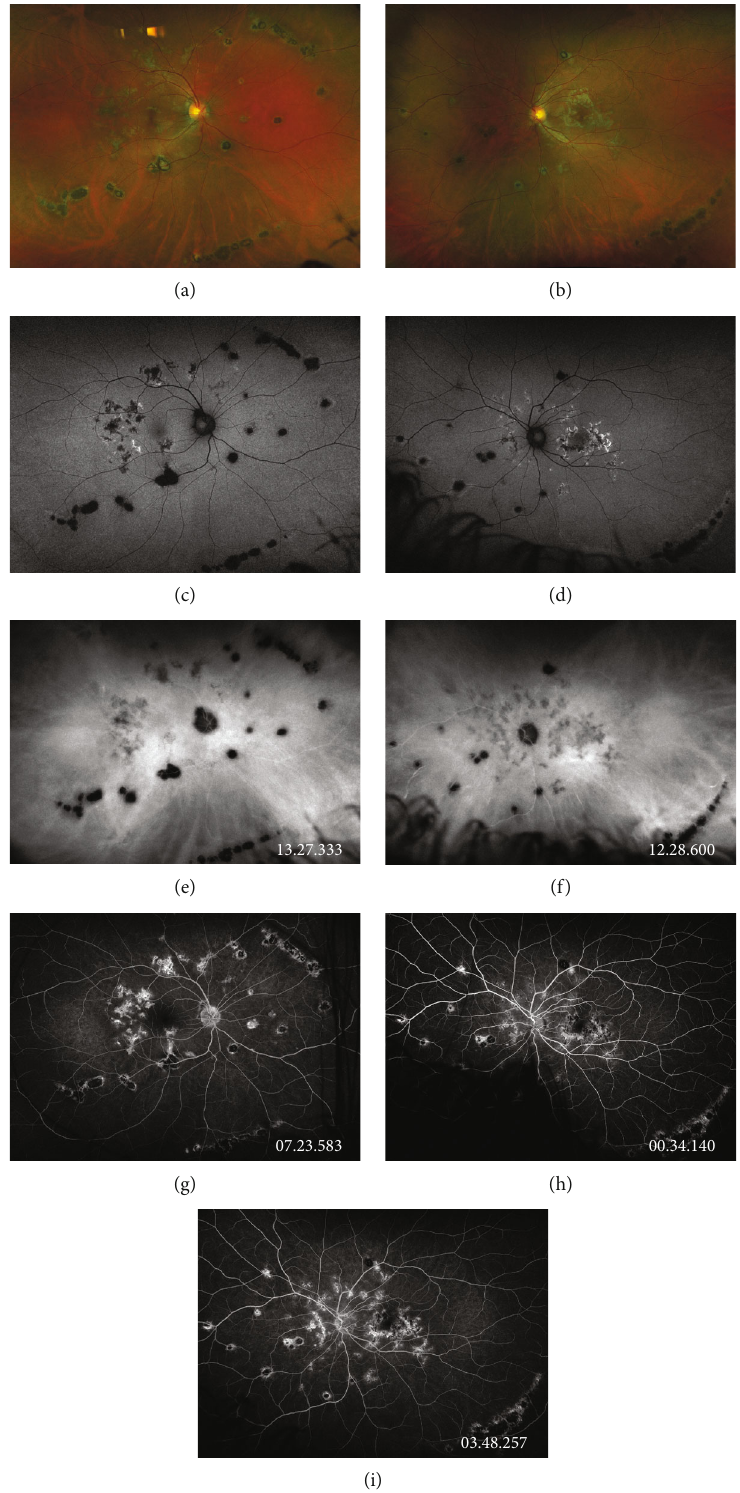
Figure 1: Multimodal fundus imaging. Optos fundus photos of the (a) right and (b) left eyes demonstrating placoid lesions in the macula and retinal periphery as well as peripheral punched-out scars in a Schlaegel line con fi guration. (c, d) Fundus auto fl uorescence exhibits hypoauto fl uorescent placoid lesions with irregular hyperauto fl uorescent borders in the posterior pole and midperiphery of both eyes. (e, f) Indocyanine green angiography displays hypo fl uorescent placoid choroidal lesions more widespread in the nasal periphery of the left eye than visible on fundus auto fl uorescence, signifying active in fl ammatory disease. Fluorescein angiography of the (g) right eye and (h) left eye early and (i) late demonstrates progressive staining and leakage from the placoid